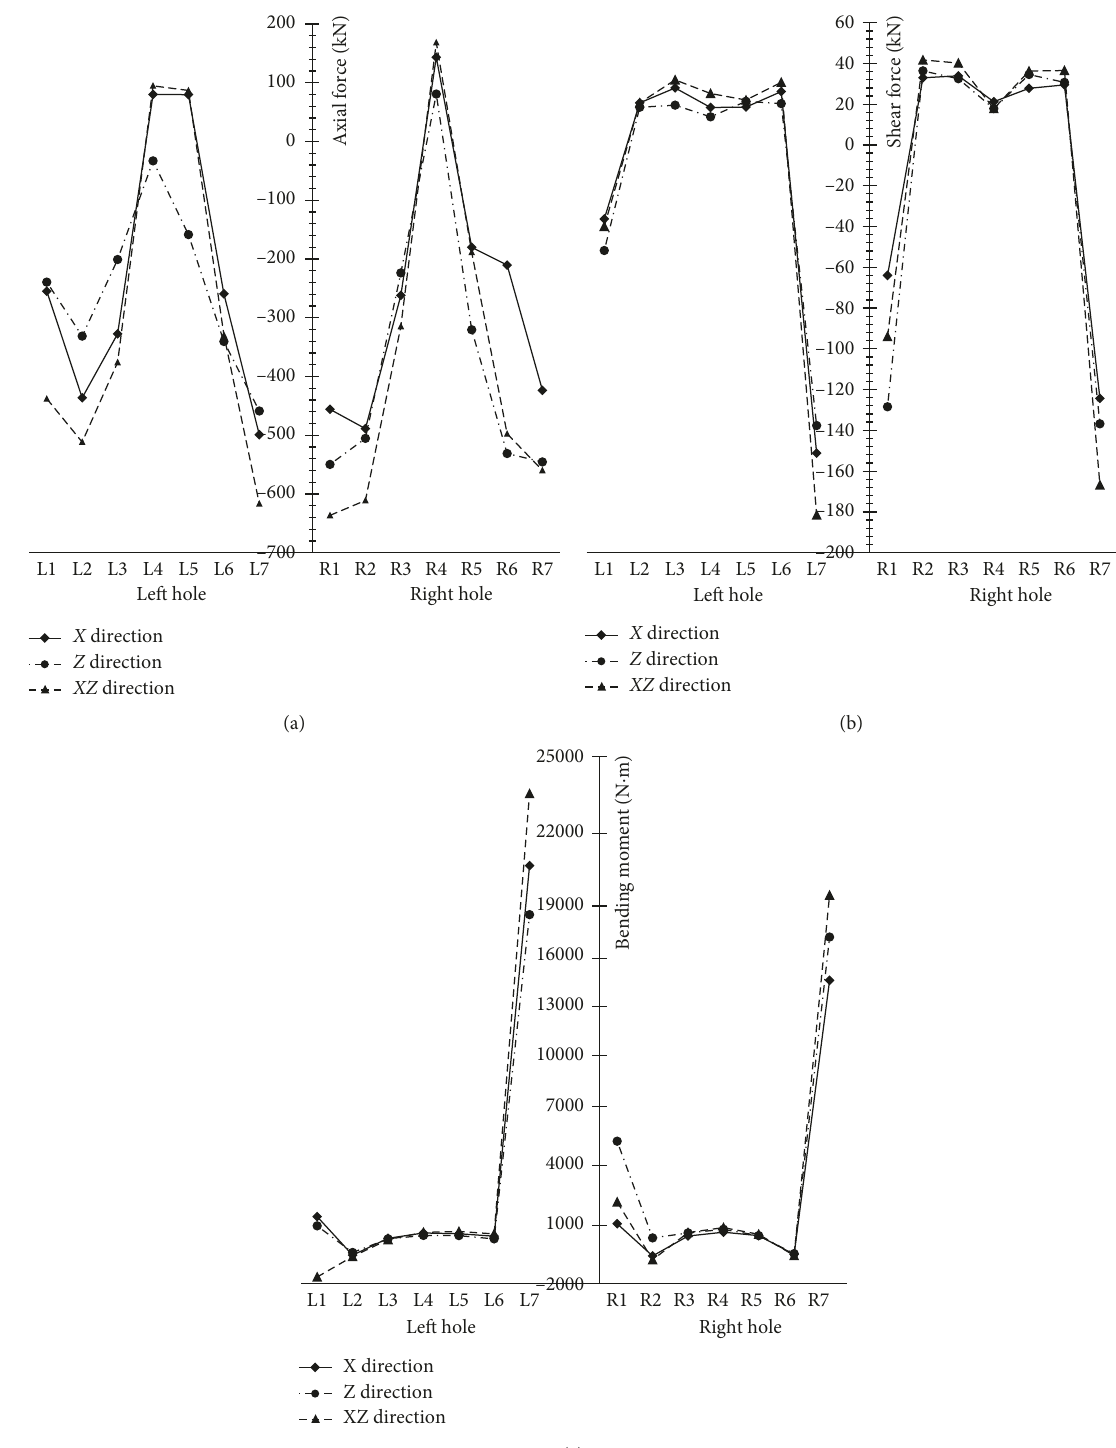
Figure 7: The internal force of lining cross section. (a) Axial force. (b) Shear force. (c) Bending